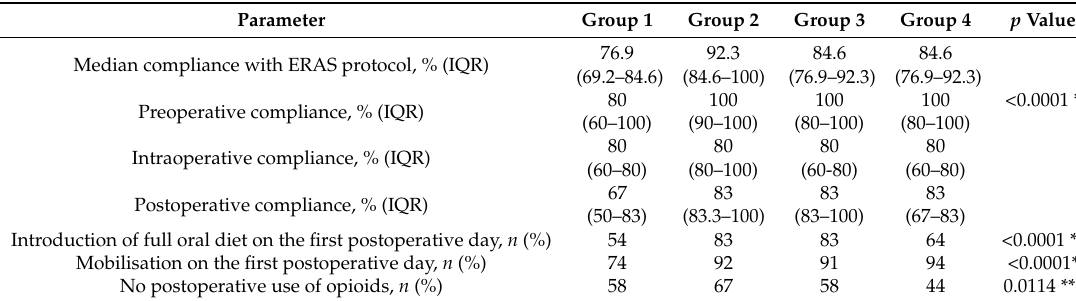
Figure 2. Compliance of the ERAS protocol elements in four groups. ERAS: Enhanced Recovery after Surgery; PONV: postoperative nausea and vomiting. Table 2. ERAS protocol